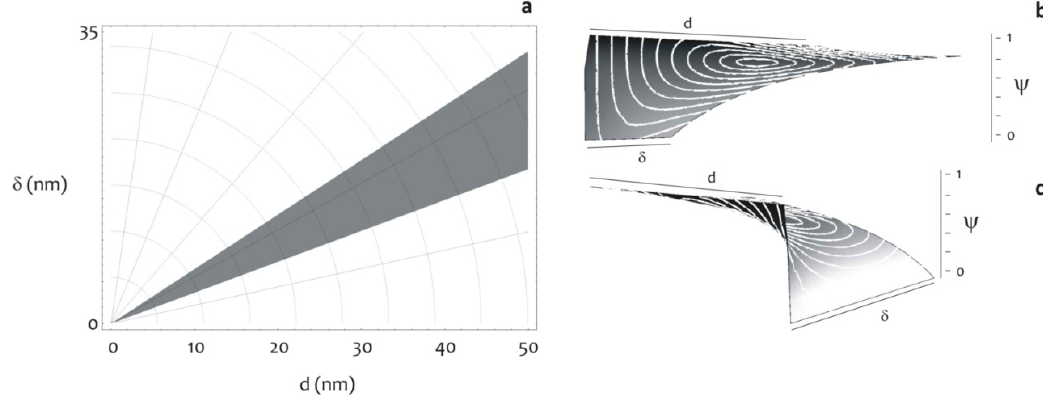
Figure 7. The diagram shows the region of optimal design, that is, the subset of pattern configurations, in terms of d and δ , which guarantee large contact angles, still retaining the advantages of a small radius of collapse ( a ). This working distance is obtained on minimizing the function, Ψ , as explained in the modeling section ( b,c